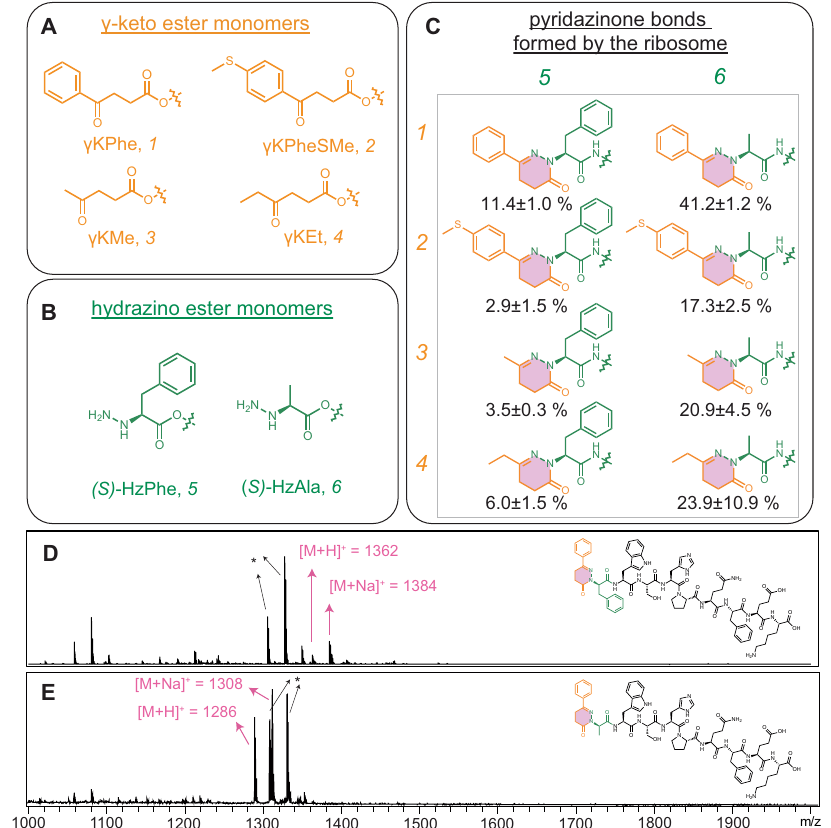
Fig.2|Designof γ -ketoandhydrazinoestersandribosome-mediatedsynthesis ofpyridazinonebonds.A Four γ -keto(orange)and B twohydrazino(green)esters were synthesized with an activated leaving group (CME, DNB, and ABT). DNB or ABT were used for the substrates that do not contain an aromatic moiety and the ABT-activated substances were only synthesized when the DNB substrates were found to be water-insoluble (Supplementary Information; 1 -CME, 2 -CME, 3 -DNB, 3 - ABT, 4 -DNB; 5 -CME, 6 -DNB, 6 -ABT). The substrates were charged to tRNA by the appropriate Fx and introduced to an in vitro translation reaction containing wild- typeribosomes. C Invitrotranslationreactionswerecarriedoutwithpairsof γ -keto ester substrates ( A ) and hydrazino ester substrates ( B ). Ribosome-catalyzed synthesis of eight different pyridazinone rings was observed. The relative percent yield of the target oligomer of all species was determined by the peak area corre- spondingtothetheoreticalmass/thesumofareasofthewholepeaksshowninthe